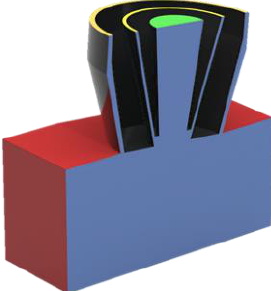
Figure 2: Coaxial Nozzle CAD (Nozzle, Carrier and Shield) with volume at